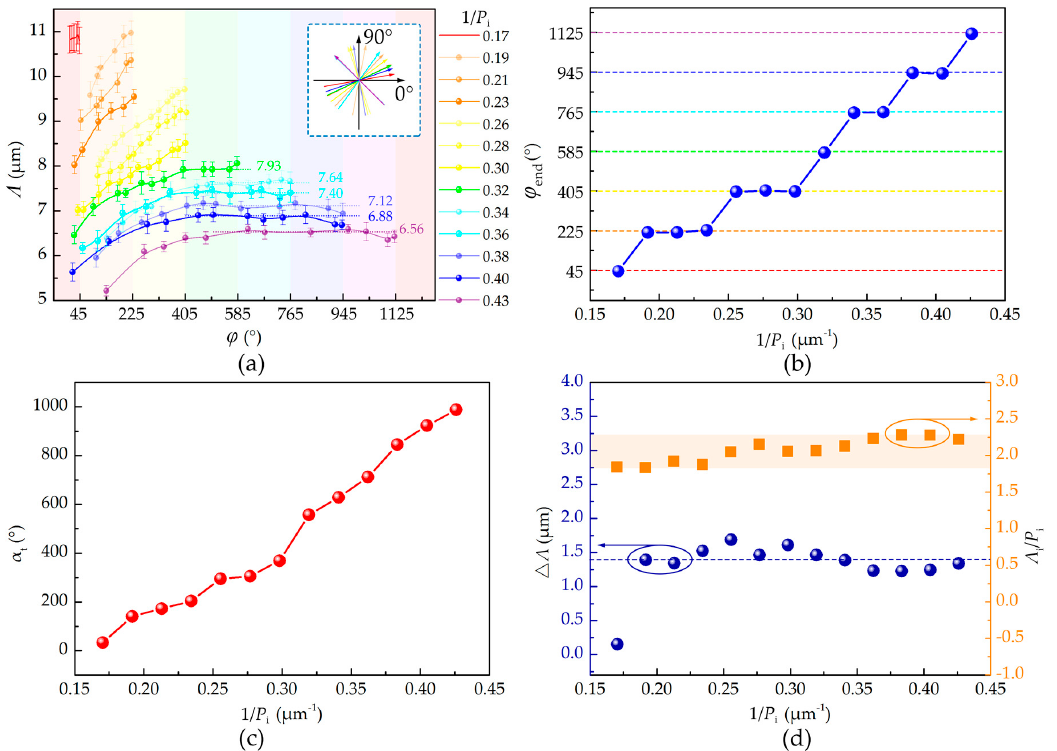
Figure 3. Dependencies of ( a ) Λ and ϕ on 1/P i , ( b ) ϕ end on 1/P i , ( c ) α t on 1/P i , and ( d ) (cid:52) Λ and Λ i /P i on 1/ P i .